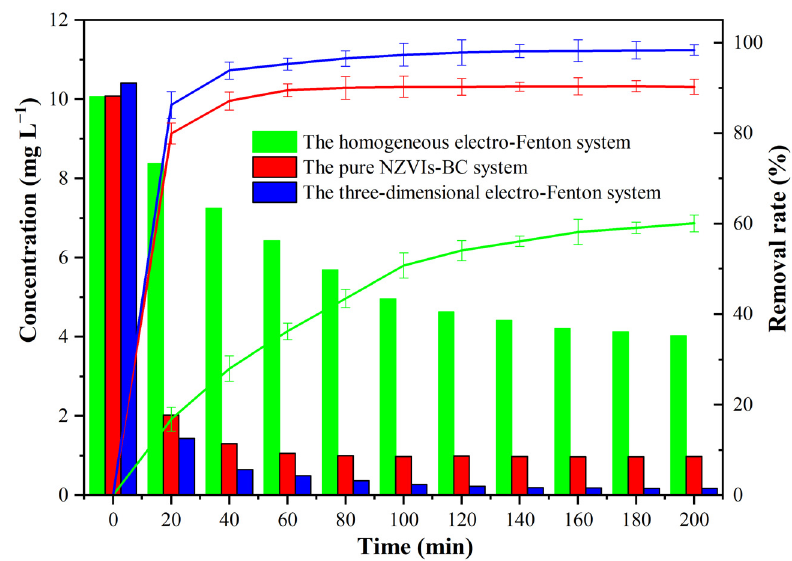
Figure 8. The removal rate of 2-naphthol by different systems.